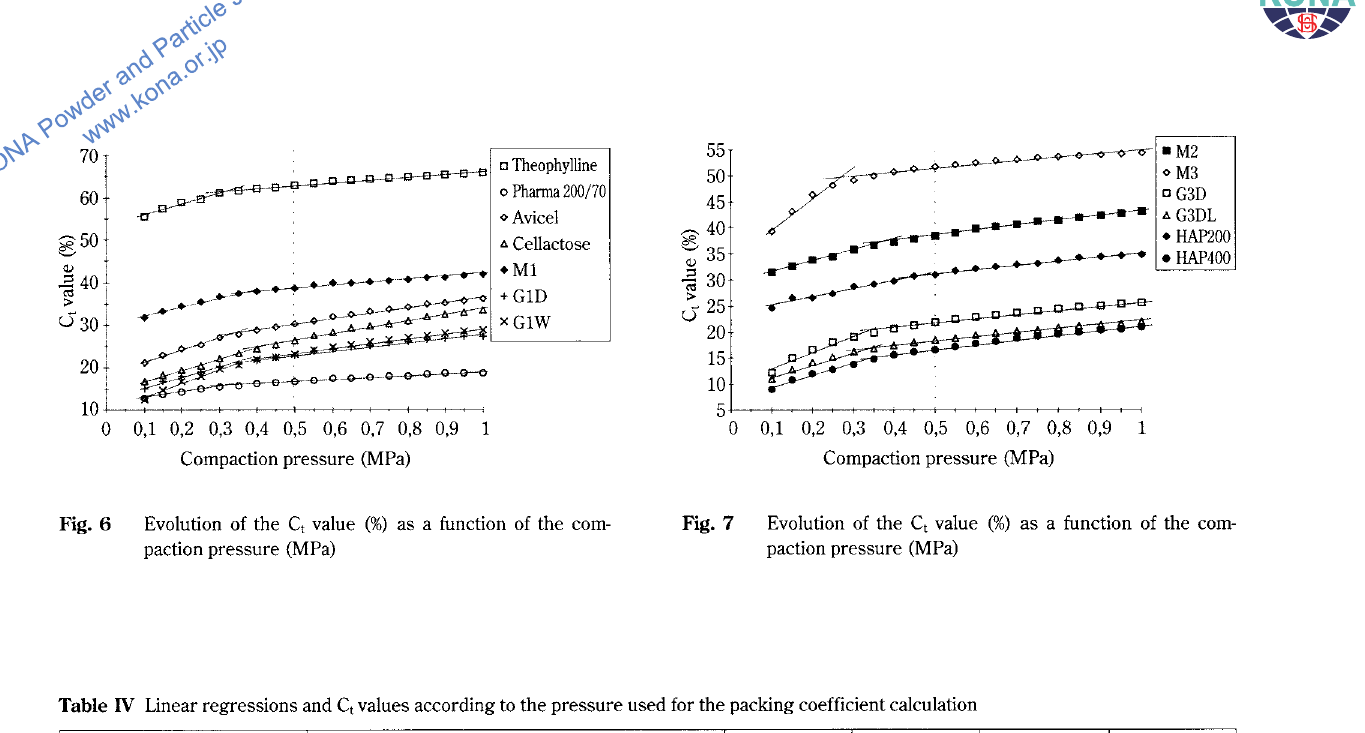
Table IV Linear regressions and C 1 values according to the pressure used for the packing coefficient